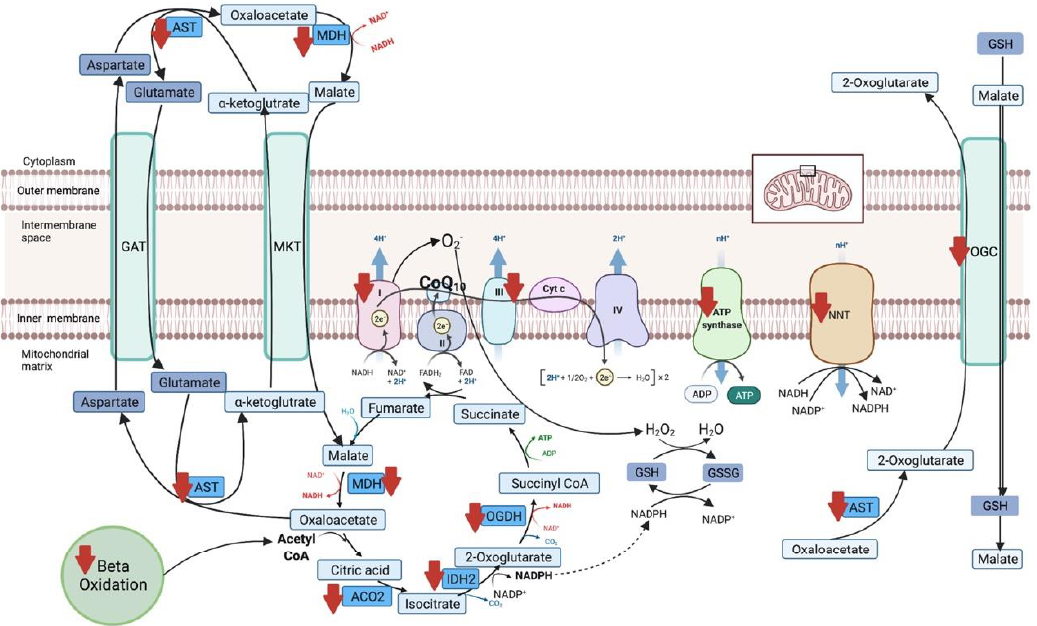
Figure 6. Proteins with significantly decreased expression (red arrow) in the mitochondria of horses on CoQ10 compared to the control. Horses with CoQ10 supplementation had a downregulation of 2 subunits of complex I, 2 subunits of complex III, and 4 subunits of ATP synthase, NAD(P) transhydrogenase (NNT), malate dehydrogenase (MDH), 2-oxoglutarate dehydrogenase (OGDH), NADP dependent isocitrate dehydrogenase (IDH2), aconitase (ACO2), aspartate aminotransferase (AST), and the 2-oxoglutarate transport channel (OGC). Created with BioRender.com, accessed on 2 December